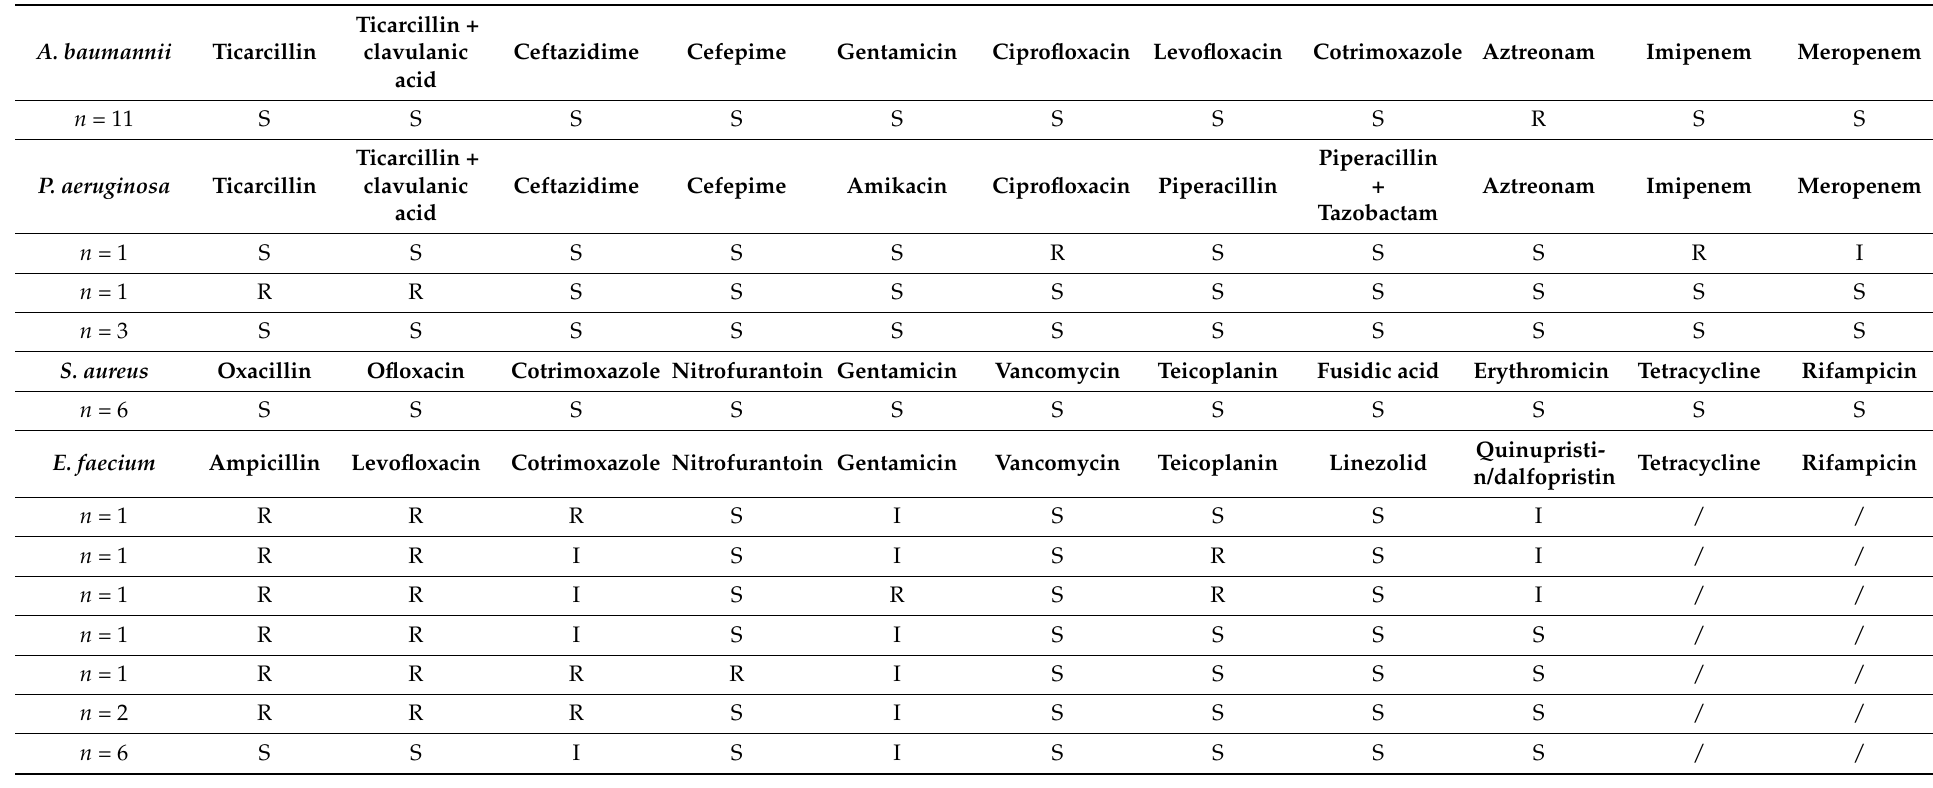
Table 1. Susceptibility pattern of the bacteria of interest ( n = 35) (R: resistant, S: sensitive; I: intermediate; /: not